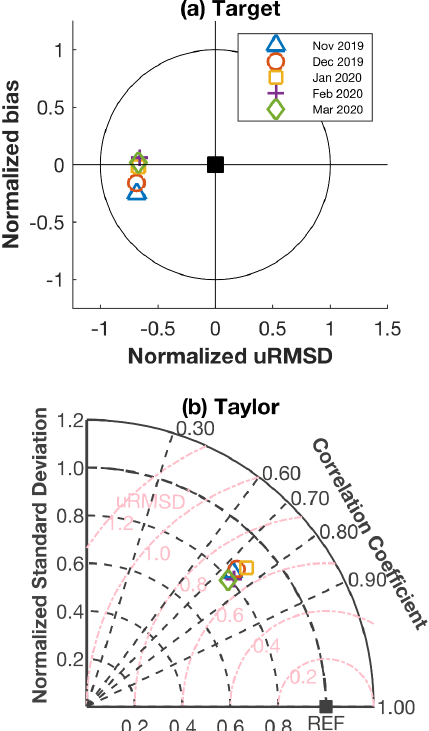
Figure 6. (a) Target diagram of the normalized bias and the nor- malized unbiased root-mean-square difference (uRMSD) and (b) Taylor diagram of the normalized standard deviation and the cor- relation between the RASM sea ice thickness simulations and CryoSat2/SMOS data from November 2019 to March 2020. The filled black square indicates the reference (REF) value, i.e., a per- fect